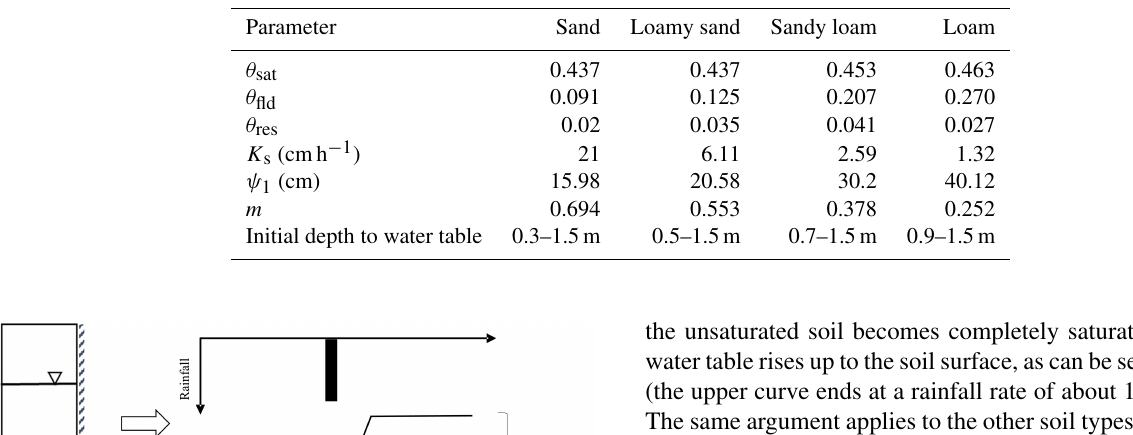
Table 1. Comparison of the subsurface flow processes in MOBIDIC–MODFLOW and MIKE SHE. Model Table 2. Hydraulic properties of the soil types used in this study, based on Rawls et al. (1982), and simulated range of initial water table depths.